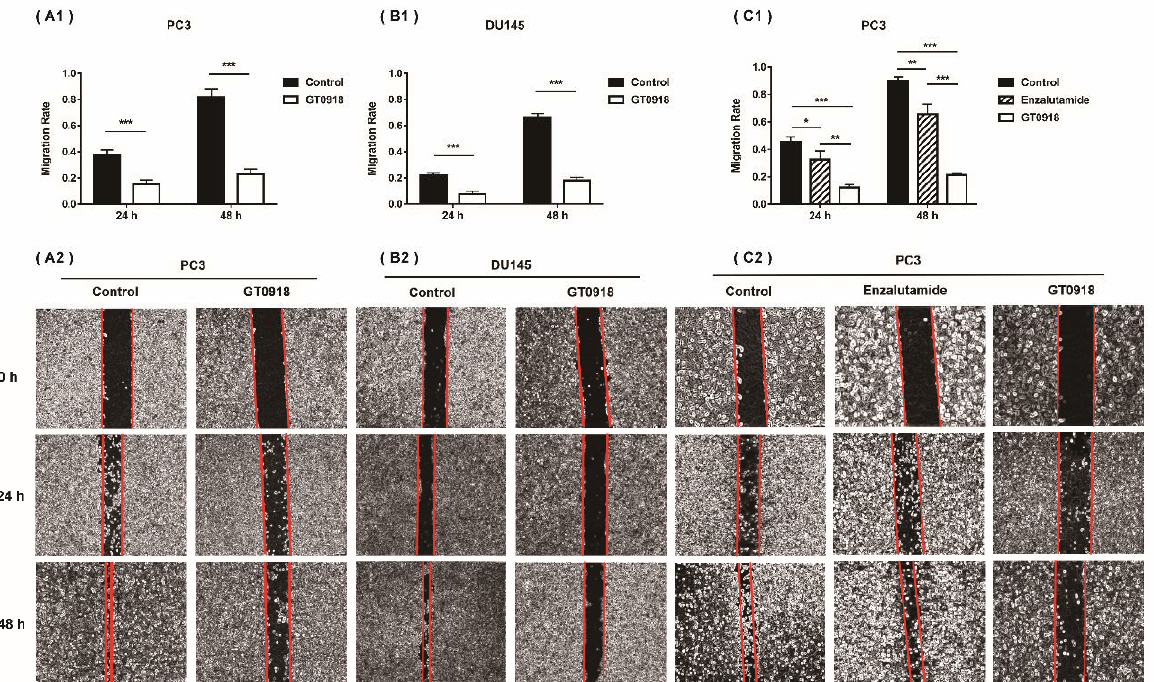
Figure 1. Proxalutamide (GT0918) inhibited the migration of PCa cells. ( A1 ) Wound healing assay of PC3 cells after exposure to proxalutamide (40 μmol/L) or control vehicle. ( B1 ) Wound healing assay of DU145 cells after exposure to proxalutamide (40 μmol/L) or control vehicle. ( C1 ) Wound healing assay of PC3 cells after exposure to proxalutamide (40 μmol/L), enzalutamide (40 μmol/L) or control vehicle. Wound closure was analyzed by the migratory rate at 24 and 48 h, respectively. Migration rate was defined as the ratio of the difference between the wound area at 0 h and the test time after injury to the wound area at 0 h. Data represent the mean ± SD of three independent experiments. * p < 0.05, ** p < 0.01, *** p < 0.001. The typical images of the migration of PC3 and DU145 cells exposed to vehicle or tested drugs are shown in the bottom panel (such as A2 , B2 and C2 ).